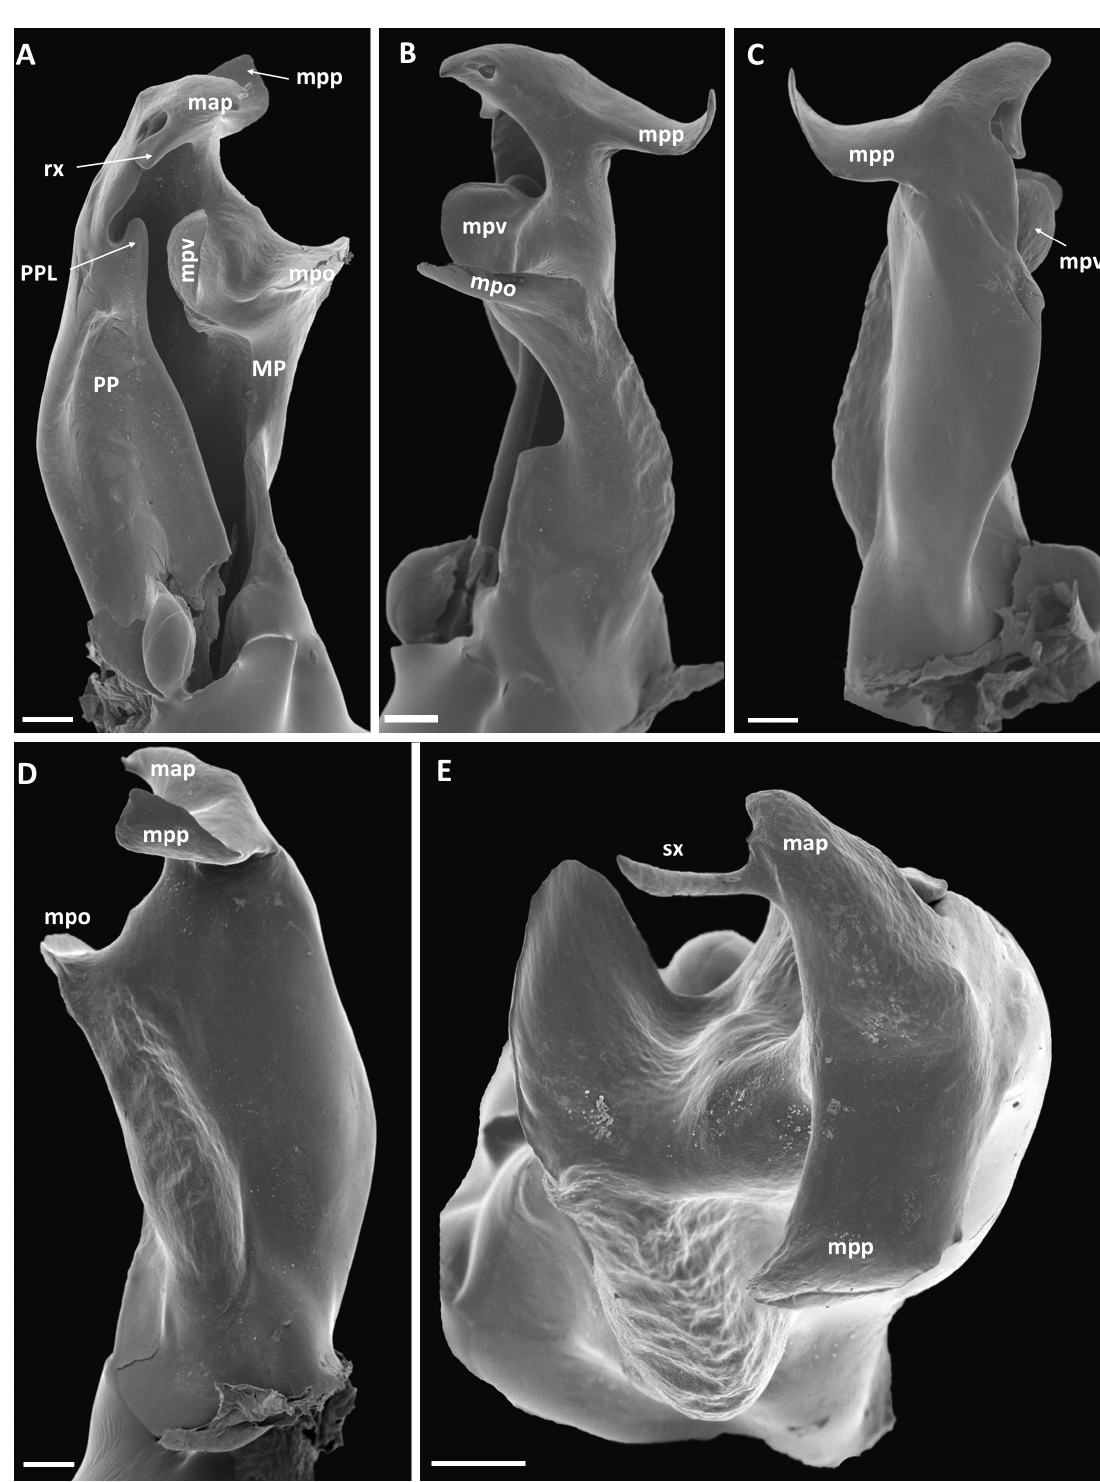
Fig. 67. Xystopyge doggartae sp. nov., holotype, ♂ (NHMD 621768), left gonopod coxa. A . Anterior view. B . Mesal view. C . Lateral view. D . Posterior view. E . Apical view. Abbreviations: map = metaplical anterior process; MP = metaplica; mpo = metaplical oblique lobe; mpp = metaplical posterior process; mpv = metaplical vertical lobe; PP = proplica; PPL = proplical lobe; rx = retrorse extension of map ; sx = straight extension of map . Scale bars = 0.1